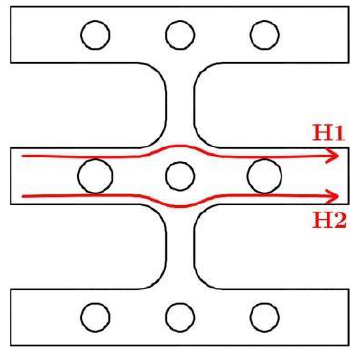
Figure 9. Scan trajectories H1 and H2 during the metallic magnetic memory (MMM) inspection. TSC-3M-12 ENERGODIAGNOSTIKA equipment supplied by PREDITEST Company (Prague,